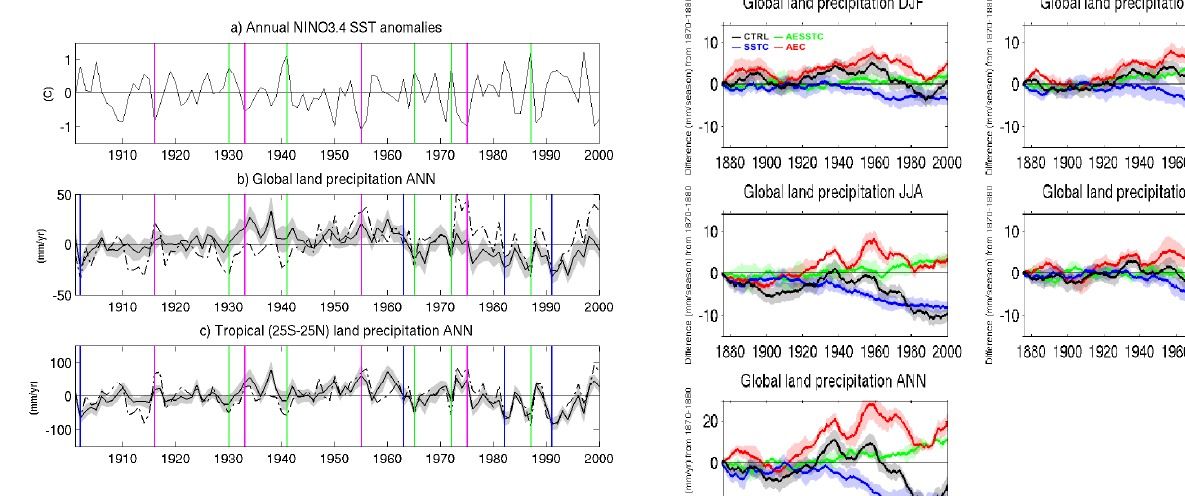
Fig. 5. Annual NINO 3.4 index anomalies calculated from observed SSTs (Rayner et al., 2003) (a) . Simulated (CTRL, solid curves) and observed (CRU, dashed curves) global (a) and tropical ( (b) 25 ◦ S–25 ◦ N) land precipitation anomalies, plotted with yearly res- olution. Here, the reference period 1901–2000 has been used. El Nino (green lines), La Nina (magenta lines) and large tropical vol- canic eruptions (blue lines) years.